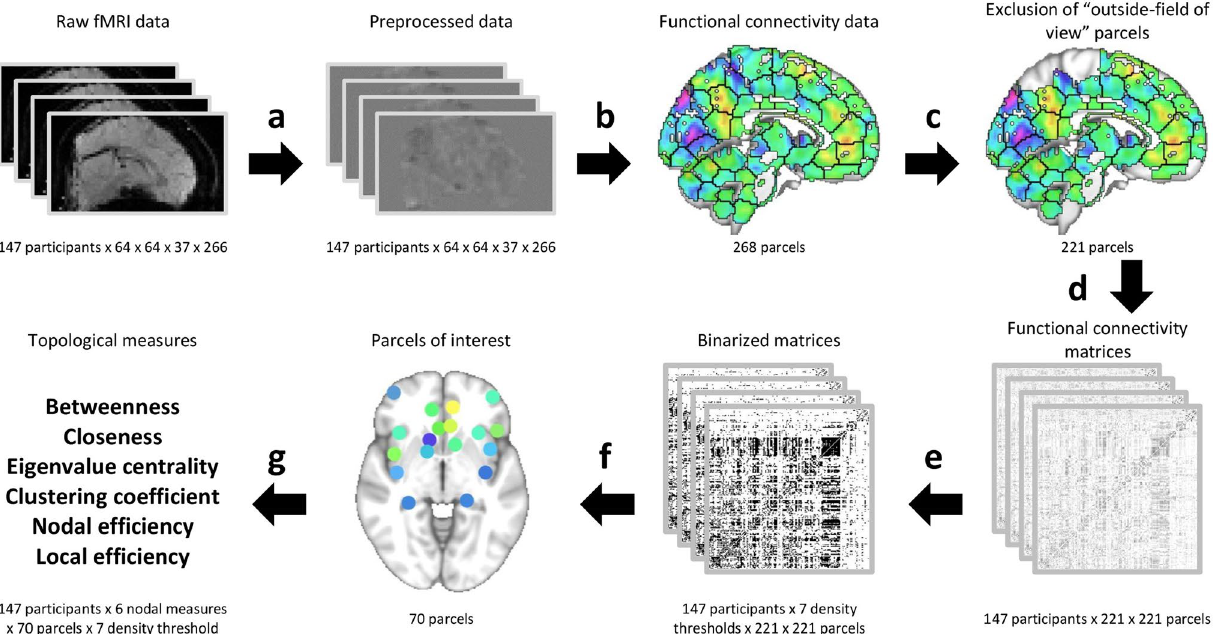
Figure 2. Resting-state functional connectivity analysis pipeline. Preprocessing included skull stripping, co-registration to structural images, realignment to middle volume, spatial smoothing (6 mm FWHM), ICA- AROMA, high-pass filtering (0.008 Hz), nuisance regression, and MNI152-space warping ( a ). Mean activation time series for parcels of functional connectivity template 20,21 were extracted after exclusion of “outside-field of view” parcels (90% of the time 80% of voxels in a parcel had to have an intensity of > 1000) ( b , c ). Individual Fisher’s z-transformed correlation matrices were created ( d ). Each correlation matrix was binarized using 7 different density thresholds (0.10, 0.15, 0.20, 0.25, 0.30, 0.35, 0.40) ( e ). Graphs were created based on binarized matrices and for 70 relevant nodes. Density-integrated as well as threshold-specific topological network measures were calculated ( f , g ). Figure was created using FSLeyes (version 0.22.6, https:// fsl. fmrib. ox. ac. uk/ fsl/ fslwi ki/ FSLey es) and R software (version 3.6.0, https:// cran.r- proje ct.